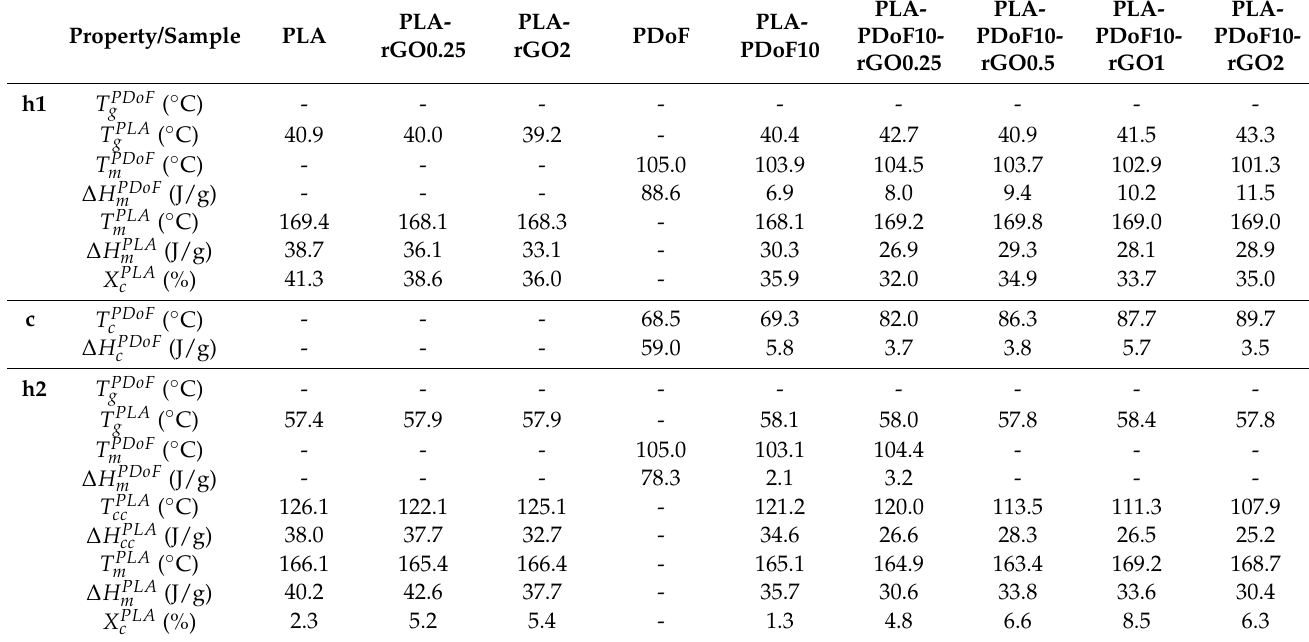
Table 2. Main results of the DSC tests on the prepared samples.